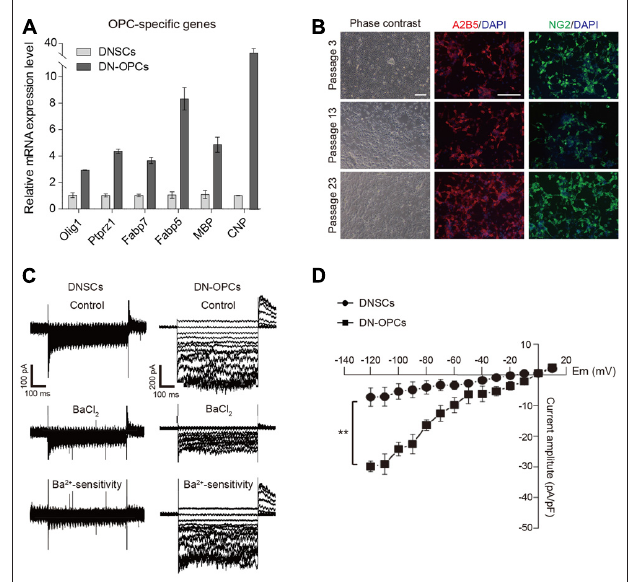
FIGURE 2 | Analysis of molecular and cellular characteristics of OPCs. (A) Quantitative RT-PCR analysis. OPCs related mRNA expression level in DN-OPCs relative to DNSCs. Graphs represent changes after normalization to NSCs. (B) Consistent morphology. Consistent morphology of OPCs at early (P3), middle (P13) and late (P23) passage. DN-OPCs can maintain steady morphology despite increase in passage. Immunofluorescence images of OPCs stained with OPC specific markers (A2B5 and NG2) at early and late passage. Cells were counterstained with DAPI. (C) Patch-clamp analysis of DNSCs and DN-OPCs. Inward K + currents in DNSCs and DN-OPCs, and the response to Ba 2 + . Ba 2 + -sensitive currents. (D) Curve of currents sensitive to Ba 2 + . Data are presented as the means ± SEM ( n = 3). Scale bar: 250 µ m. ∗∗ p <